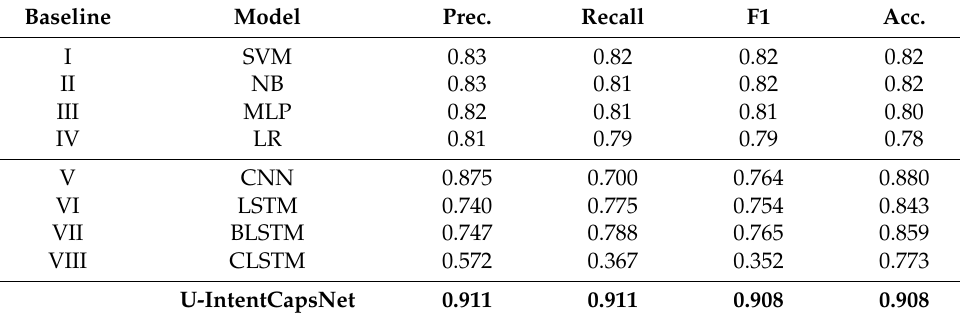
Table 10. Precision, recall, F1 scores and accuracy of intent detection for baseline and the proposed U-IntentCapsNet